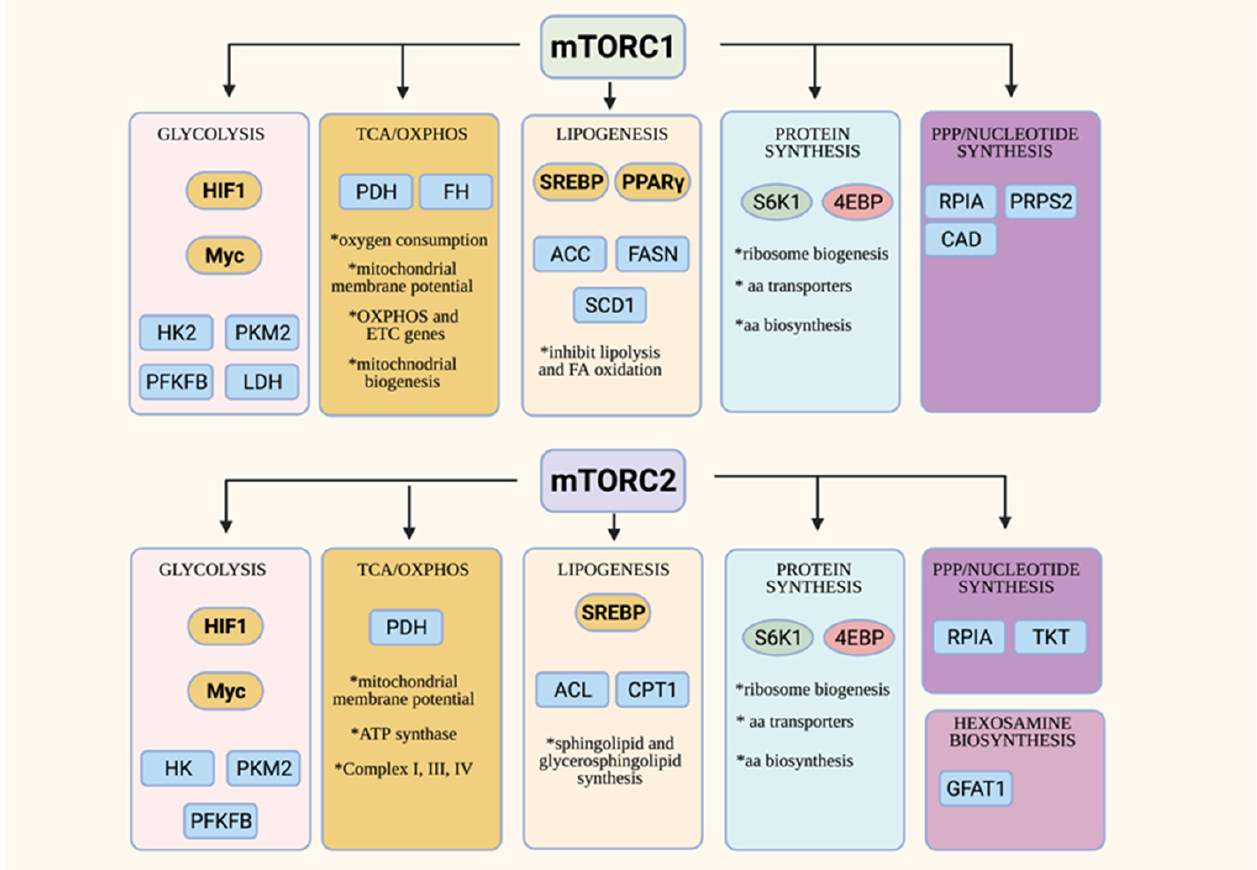
Figure 2. Overview of metabolic functions of mTORC1 and mTORC2. Both the mTORC1 and mTORC2 control metabolic processes via modulating transcription factors that are involved in metabolic pathways (in yellow ovals) and/or the control of other metabolic enzymes or transporters (in blue squares).